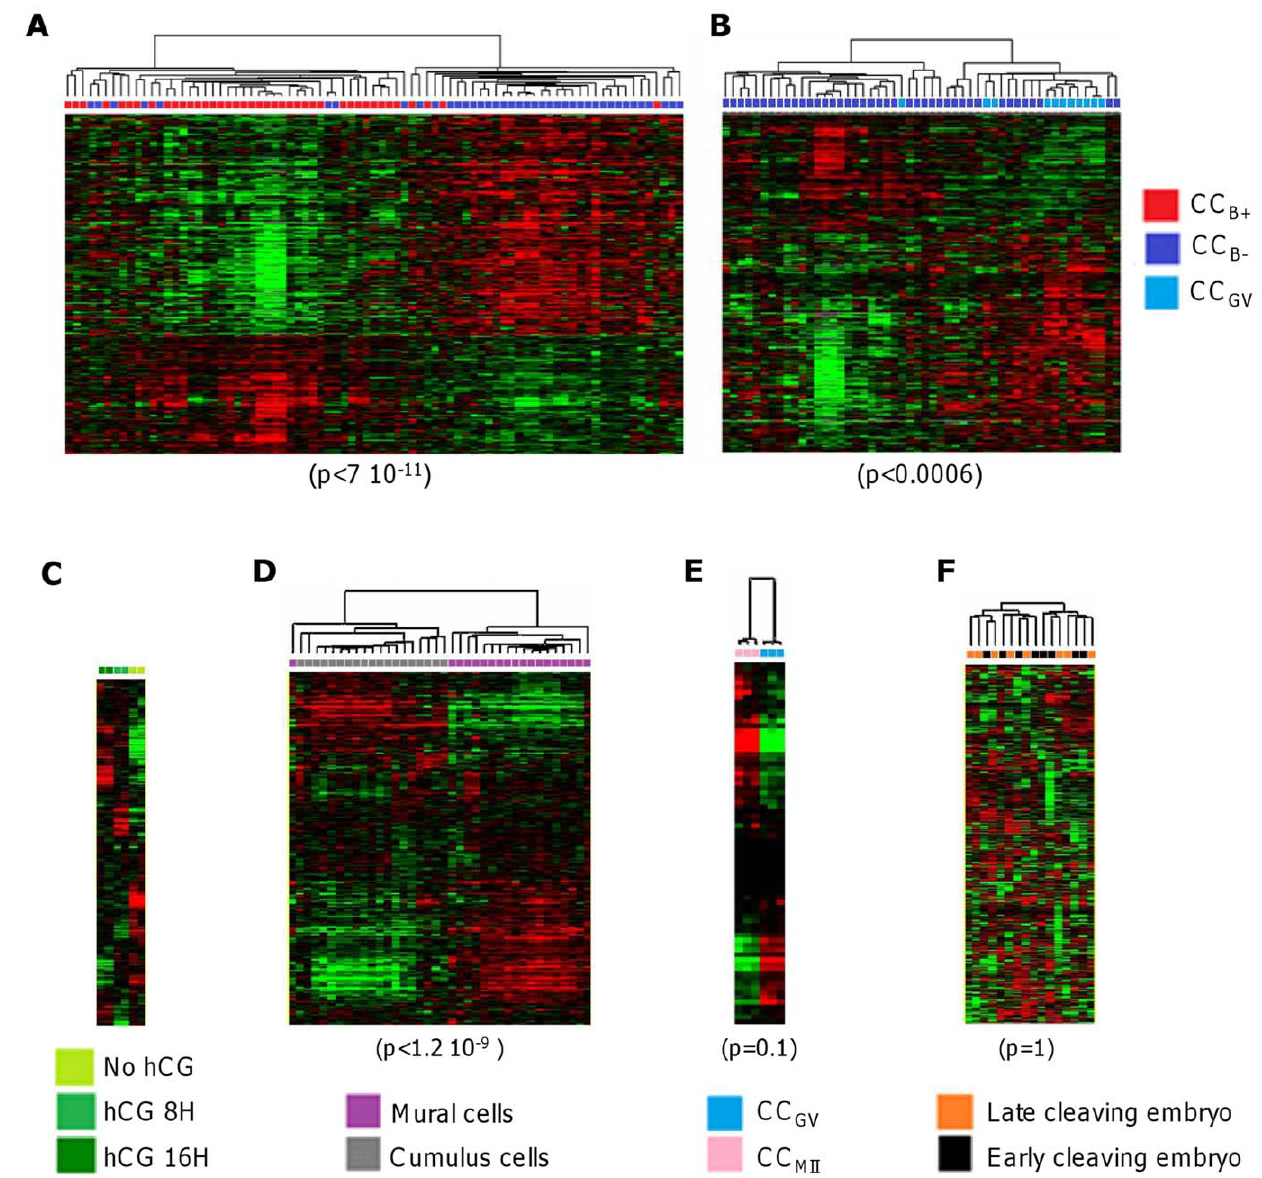
Figure 4. Hierarchical clustering of microarray datasets. Measurements of the 308 genes discriminating CC B- and CC B + were extracted from different datasets: our study (A, B), GSE4260 (C), GSE18559 (D), GSE21005 (E) and GSE9526 (F). They were subjected to hierarchical clustering after log transformation and median centering of genes. The different types of sample are shown as coloured squares. The quality of the separation was measured by Fisher’s exact test on the main branch. CC GV , cumulus cells from immature oocyte at germinal vesicle stage; CC MII , cumulus cells from mature oocyte; CC B + , cumulus cells from mature oocyte yielding a blastocyst at day 5/6 of in vitro culture once fertilised; CC B-, cumulus cells from mature oocyte which stopped developing at the embryo stage at day 5/6 of in vitro culture once